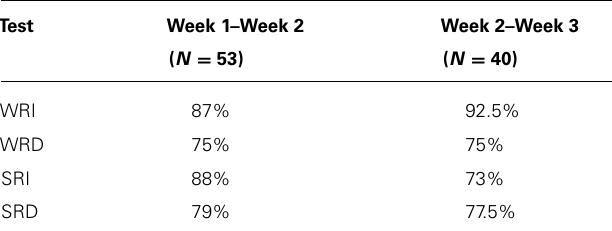
Table 2B | Percentage agreements of memory tests scaled scores, between first and second and between second and thirdACAD